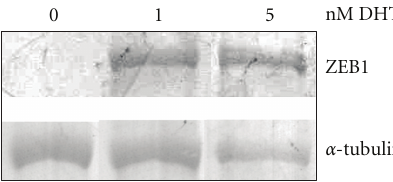
Figure 2: Expression of ZEB1 protein is induced by DHT . Protein was isolated from PC-3/AR cells treated with the indicated amounts of DHT for 24 hrs. One hundred mg of protein was used for western blot analysis with a ZEB1 antibody or an α -tubulin antibody as a loading control. The ∼ 150 kDa ZEB protein and the 45 kDa α - tubulin protein are